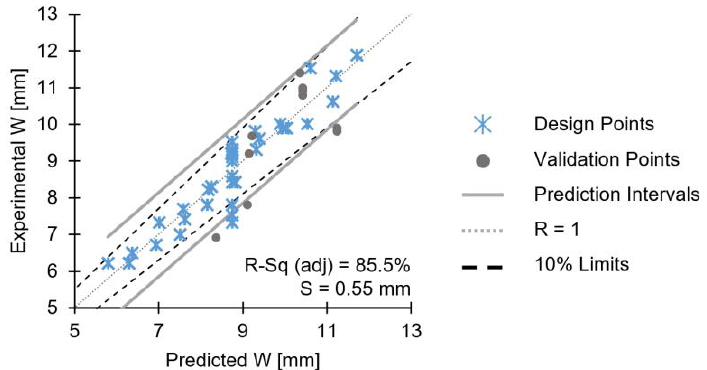
Figure 14. Validation diagrams for the reduced model of W.